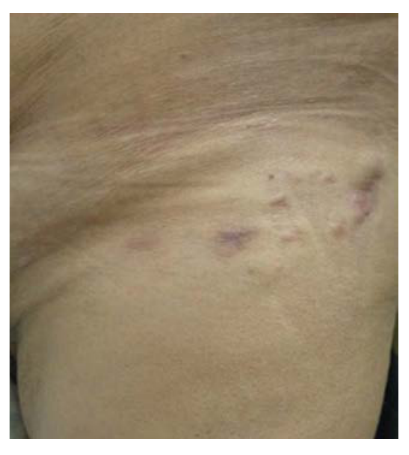
Figure 1. Cluster of deep red-to-brown firm, indurated erythematous nodules on the left upper